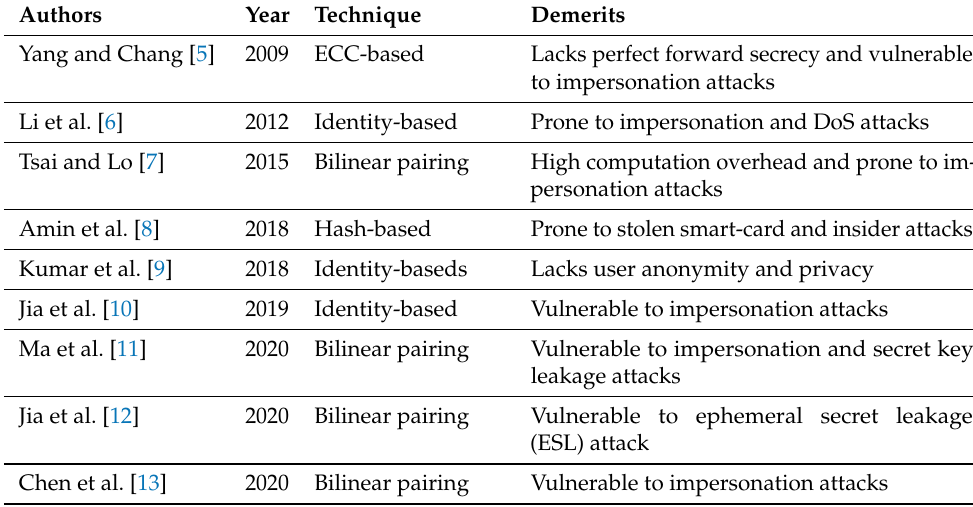
Table 1. Summary of existing